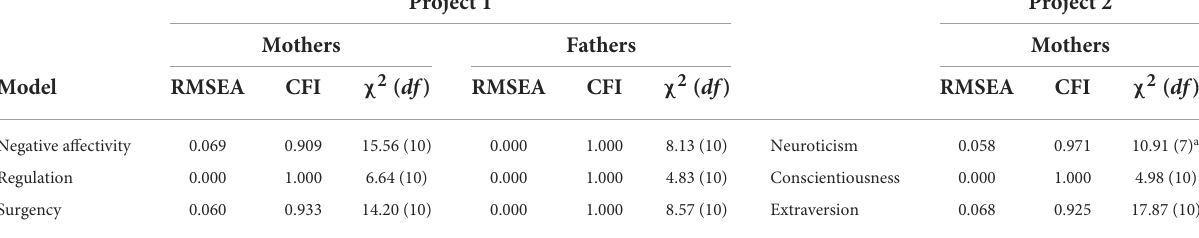
TABLE 3 Model fit statistics.